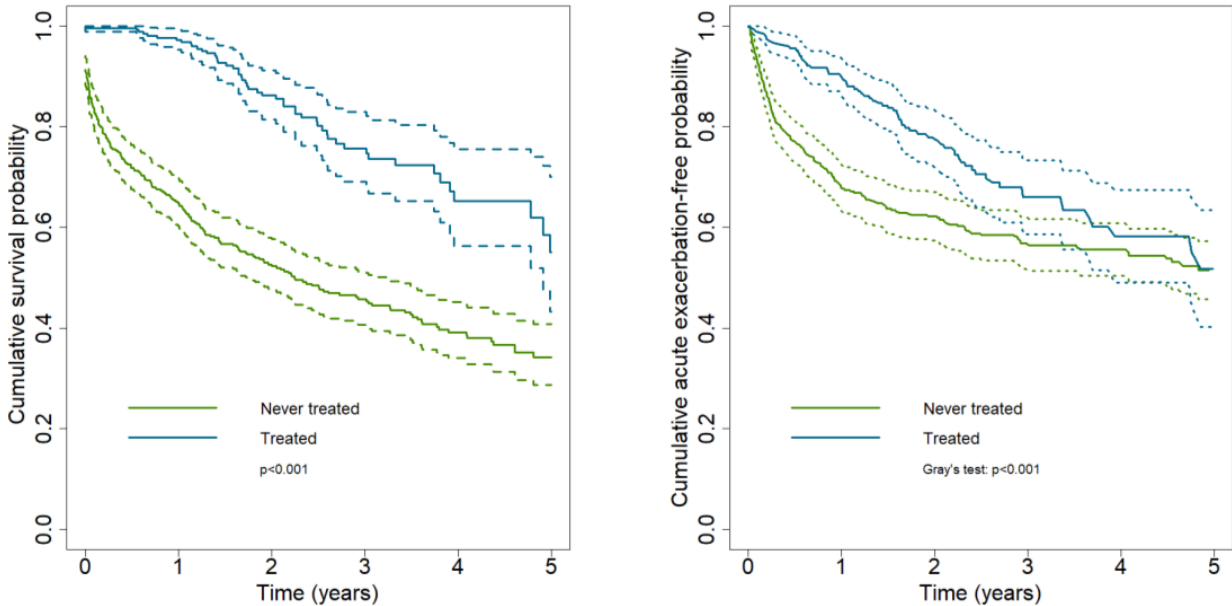
Figure 1. Kaplan–Meier cumulative survival and acute exacerbation-free probability curves according to treatment status (Treated: patients with at least one prescription of antifibrotics during the follow-up were considered as treated). The cumulative acute exacerbation-free probability is calculated considering death as a competing risk event. (Dashed line: 95% confidence band).